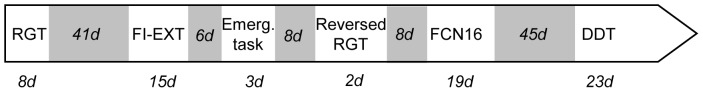
Order and duration of behavioral tasks.The number of days (d) of each behavioral testing phase (below arrow) and inter-test periods (grey zones) are indicated. RGT: Rat Gambling task, FI-EXT: multiple fixed-interval/extinction schedules, Emerg. Task: Light-dark emergence task, FCN16: Fixed consecutive number 16 cue schedule, DDT: Delay discounting task.